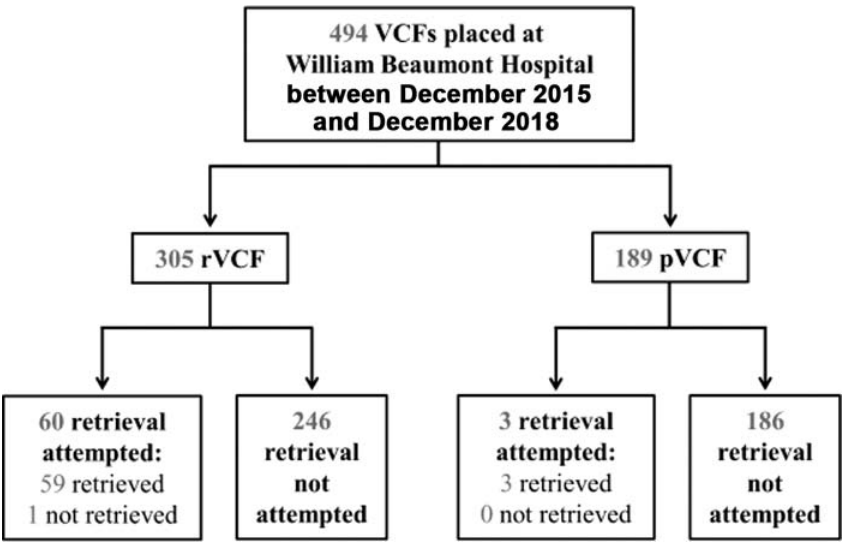
Fig. 1 Outline of study population. pVCF, permanent vena cava fi lter; rVCF, retrievable